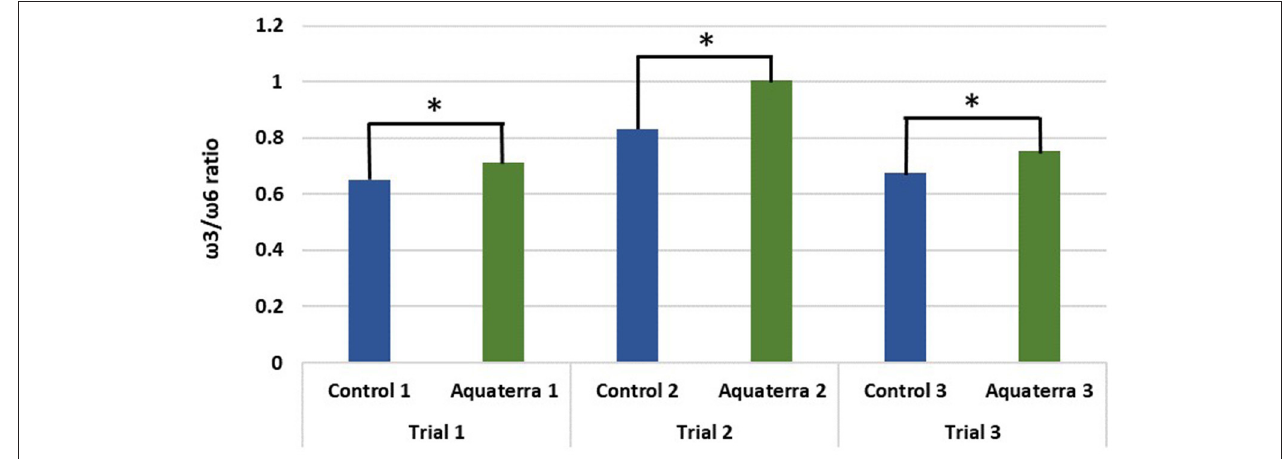
FIGURE 3 | ω 3/ ω 6 ratio in filets raised on the Aquaterra Omega-3 oil and control diets. *Statistically significant difference with 95% confidence level.